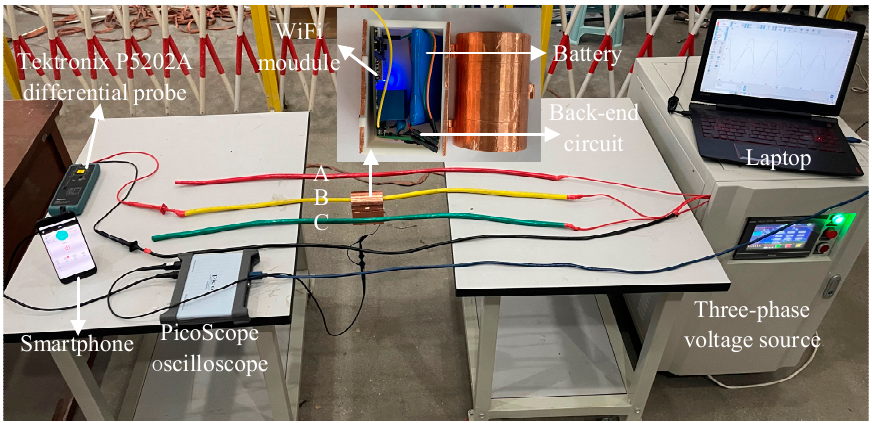
Figure 6. Experimental testing platform.